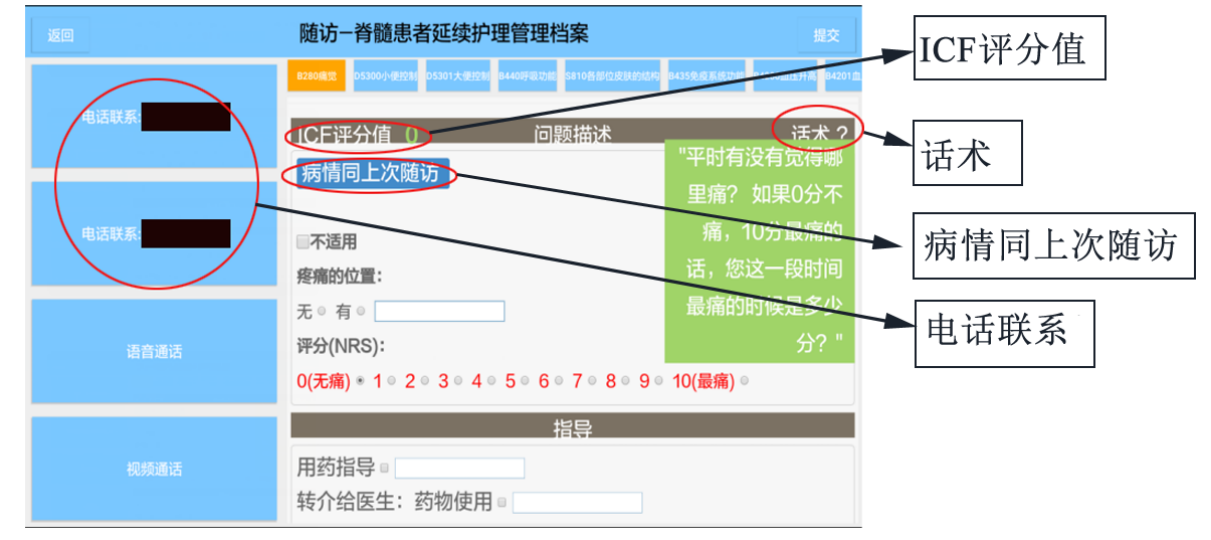
Figure 2. Health education interface for the category of "b4200 Increased blood pressure." 指导 means “Health education.” 指导内容 means “Health education contents.” The health education contents for the ICF category "b4200 Increased blood pressure" are as follows: (1) the attitude toward preventing AD is positive and cautious; (2) instructing patients in the monitoring of AD; (3) instructing patients in the treatment of AD; (4) instructing patients in the prevention and management of AD; (5) medication guidance; and (6) others. AD: autonomic dysreflexia; ICF: International Classification of Functioning, Disability, and Health.